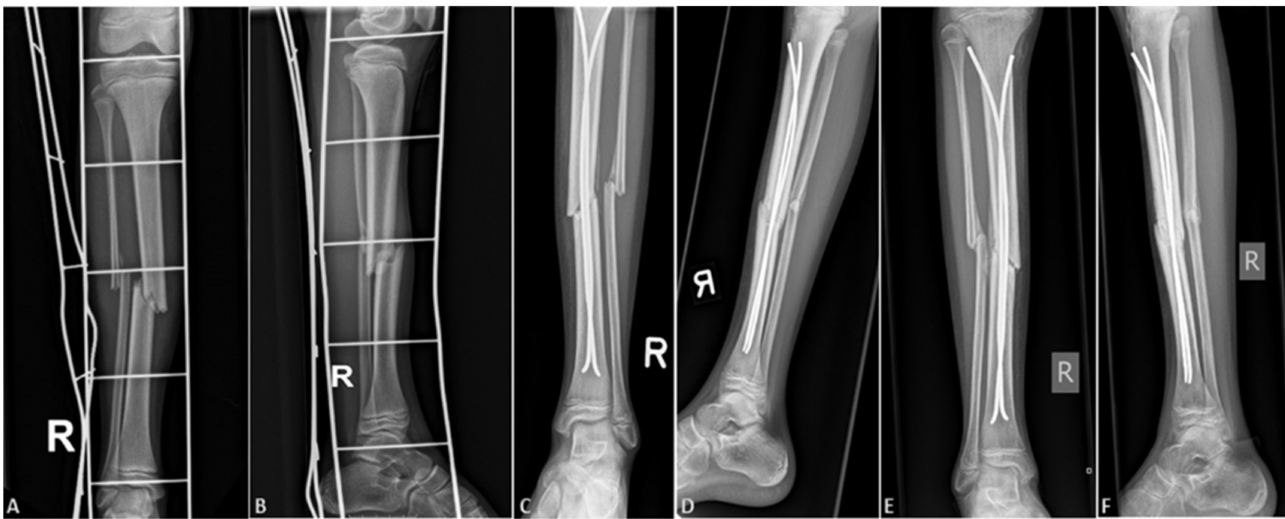
Figure 1. Displaced tibial shaft fracture in 11-year-old female patient: ( A ) preoperative AP radiograph; ( B ) preoperative LL radiograph; ( C ) AP radiograph one month after surgery; ( D ) LL radiograph one month after surgery; ( E ) AP radiograph three months after surgery; ( F ) LL radiograph three months after